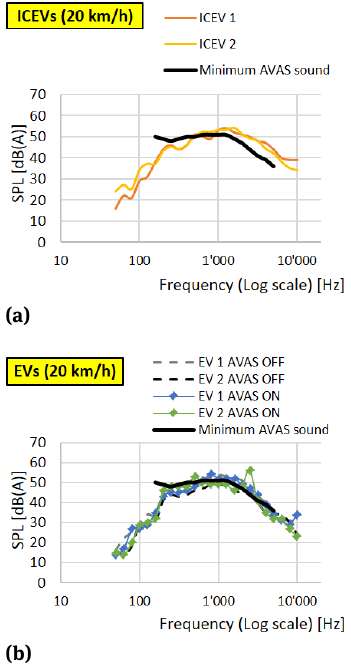
Figure 7: A-weighted Sound Pressure Level (ISO 362-1-1:2015) of the required AVAS sound vs. those of ICEVs and EVs (with AVAS on and off) moving at 20 km/h based on the study [62] and the ECE regulation [55].